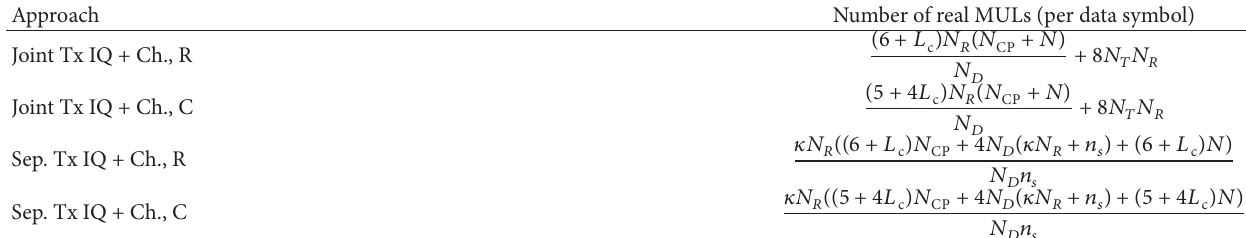
Table 5: Computational complexity expressions for the actual compensation.